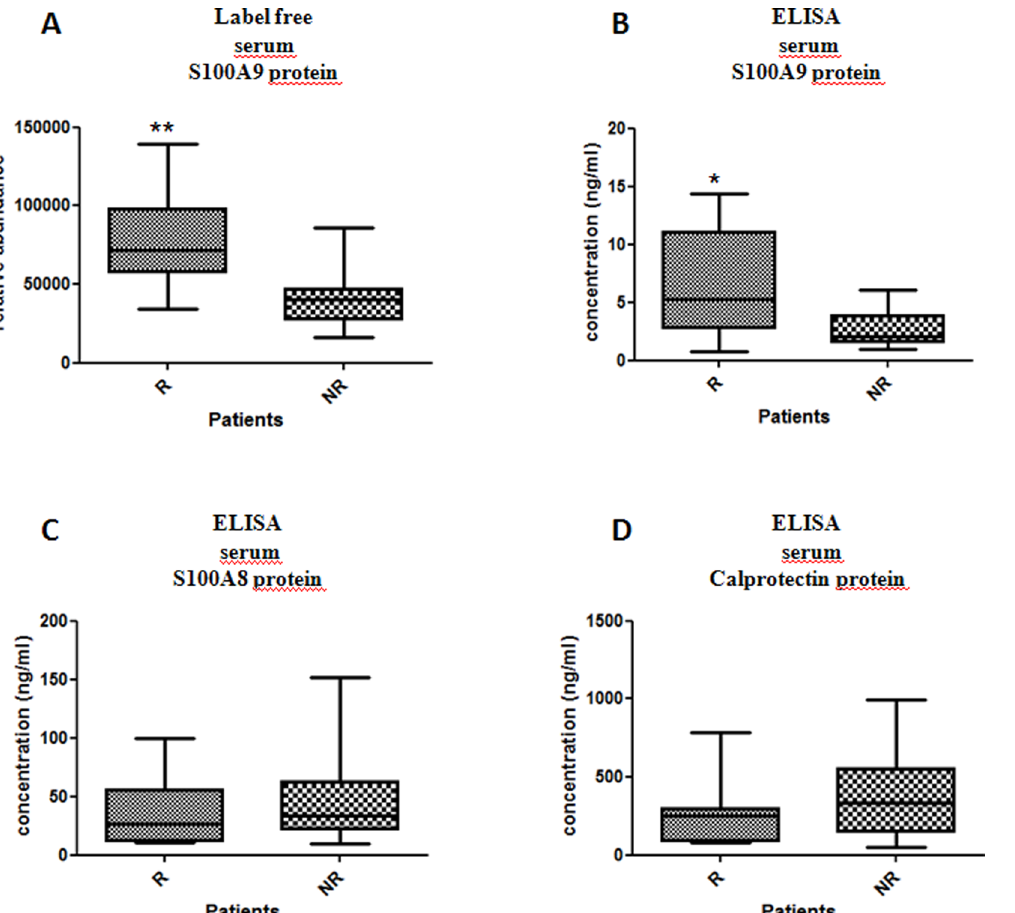
Fig. 3. Over-expression of the S100A9 protein in baseline serum from responder patients to the MTX/ETA combination according to 2 different approaches in the second population. Relative quantification of serum S100A9 protein at baseline in R (n 5 12) versus NR (n 5 10) by mass spectrometry (A). This result showed an over-expression of S100A9 protein in R patient (p-value 5 0.0022). Serum ELISA absolute quantification of S100A9 (B), S100A8 (C) and calprotectin (D) at baseline in responders versus non-responders. No significant difference in the expression of S100A8 protein and calprotectin was observed between R and NR (p-value 5 0.75 and 0.32, respectively). Only S100A9 showed an over-expression in R patients (p-value 5